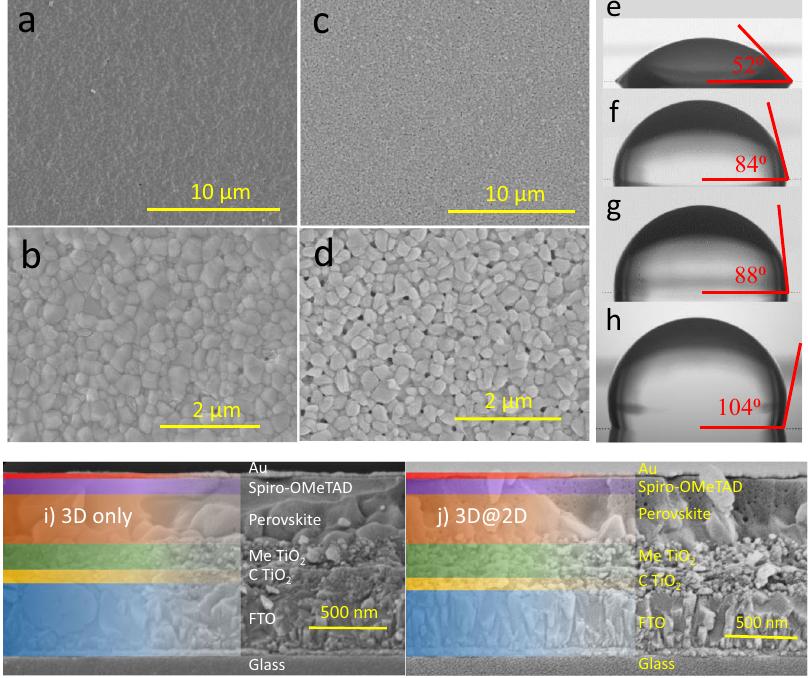
Fig. 4 Surface morphology and device architecture. Scanning electron microscopy (SEM) images of ( a , b ) pure 3D and ( c , d ) C18 perovskite-coated 3D perovskite fi lm, respectively. Contact angle made by a water droplet on the surface of thin fi lms of ( e ) pure 3D perovskites and ( f ) C14-, ( g ) C16-, ( h ) C18- coated 3D perovskite measured after stabilizing the water droplet for 10 s. Cross-sectional SEM images of ( i ) pure 3D and ( j ) 3D@2D